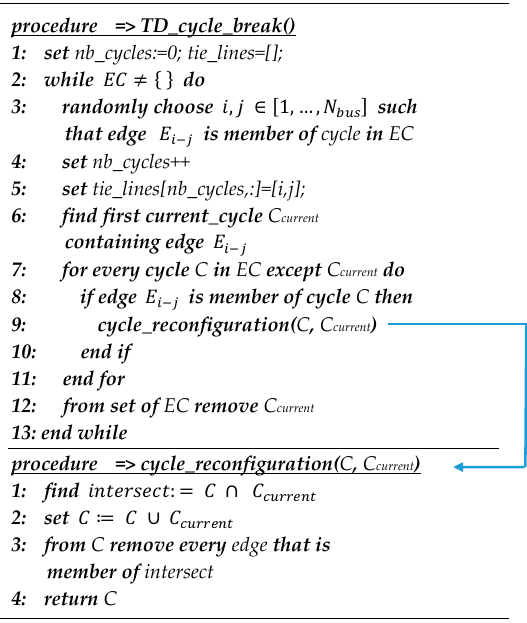
Algorithm 2 . Pseudocode for TD cycle break algorithm.